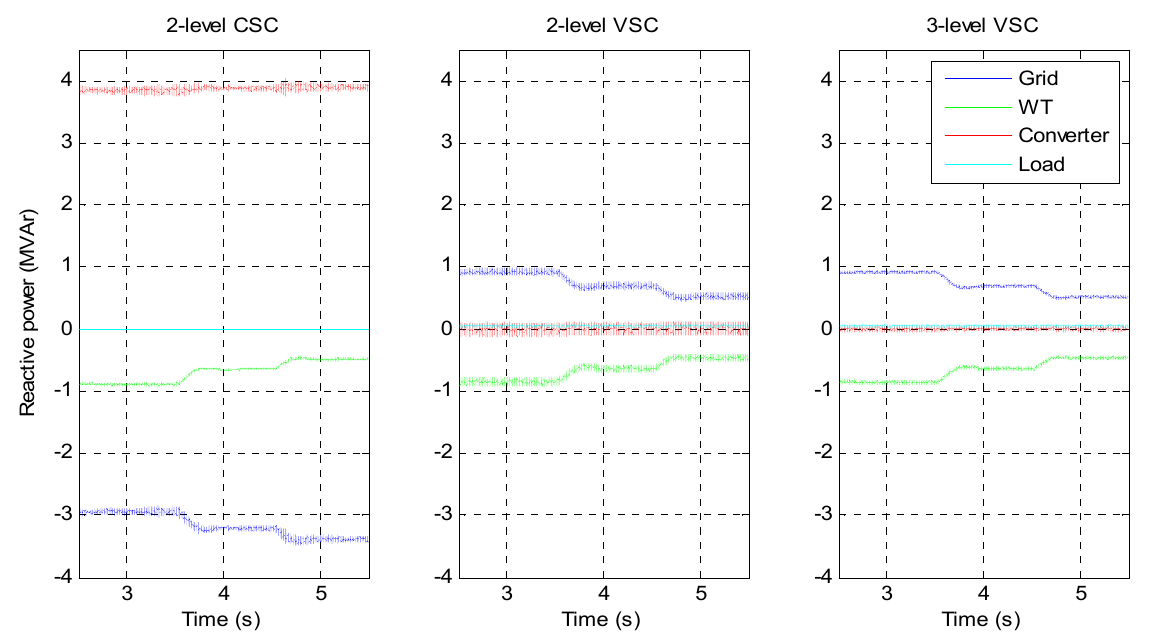
Figure 18. Grid, WT, converter and load reactive power in each